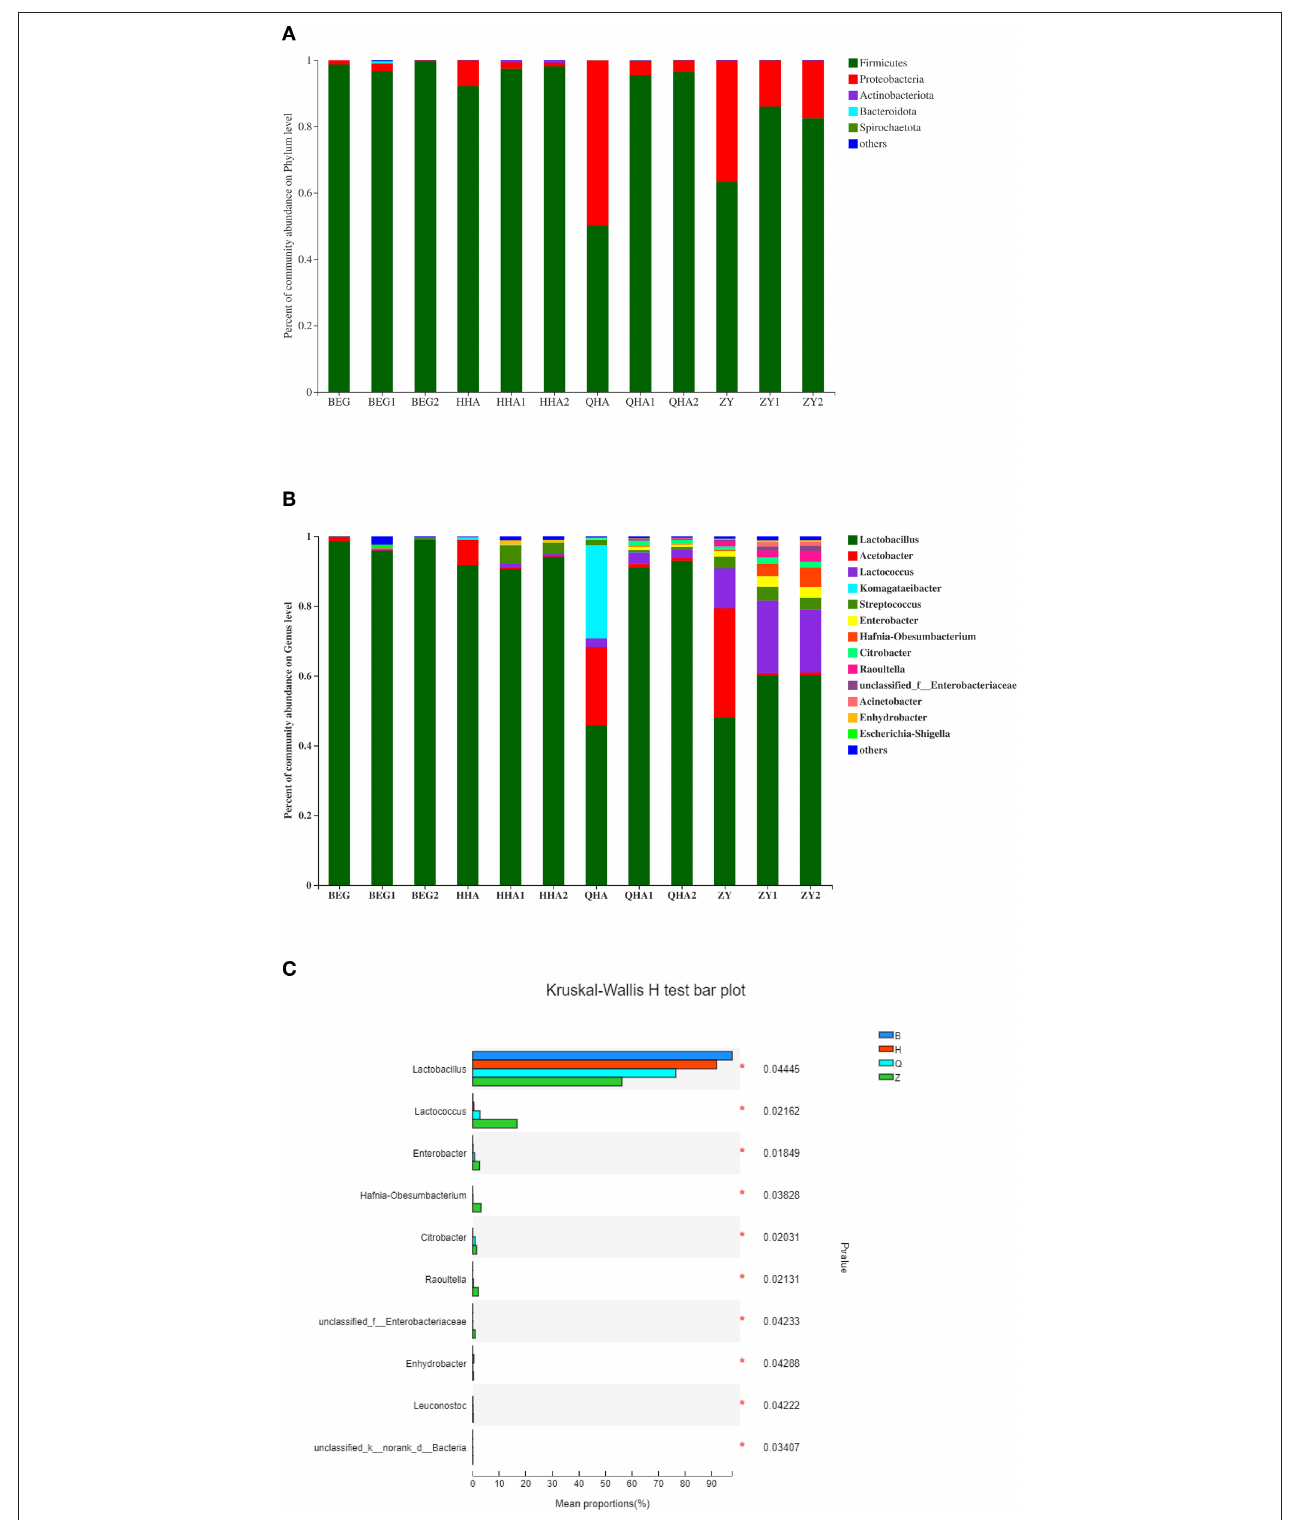
FIGURE 5 | Bacterial community structure of different Hurunge samples. (A) Phylum level and (B) Genus level. (C) Relative abundance at genus level with the significant difference among samples from different regions. The proportion of which is less than 1% is not listed.